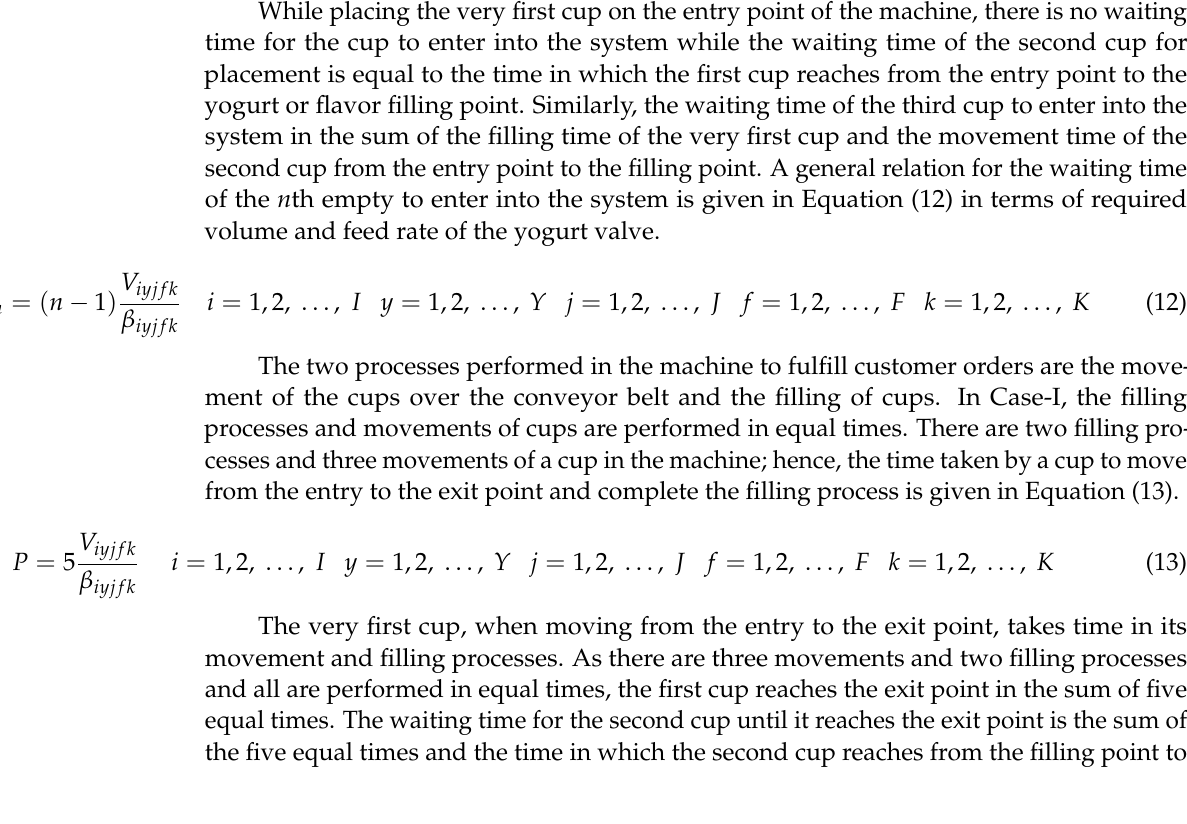
Table 2. All combinations of yogurt mixing with three flavors. Yogurt Flavor 1 Flavor 2 Flavor 3 V min (mL) V max (mL)